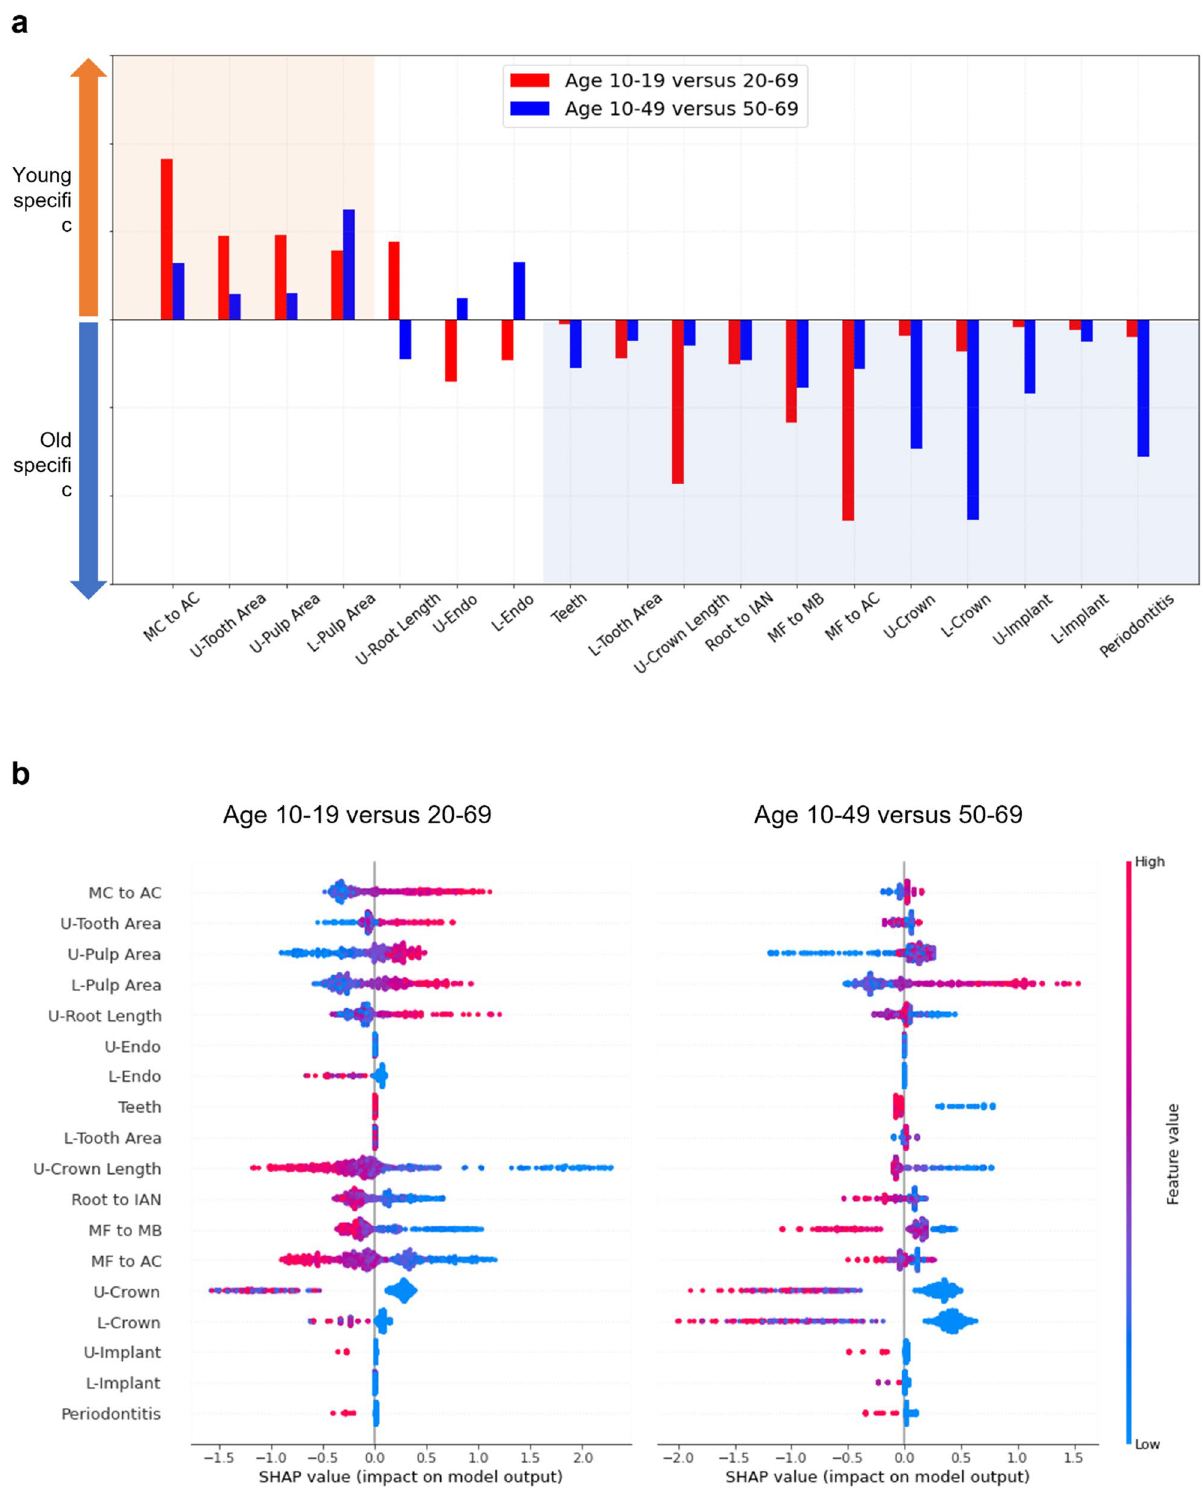
Figure 5. Feature analysis for LDA and XGBoost in young and old age group classifications ( a ) Learned weights of LDAs are shown as red bars (10–19 years versus 20–69 years) and old (10–49 years versus 50–69 years). The orange shaded area shows the features identified as young-specific: MC to AC, U-Tooth Area, U-Pulp Area, and L-Pulp Area. The light blue shaded area displays the old-specific features: Teeth, L-Tooth Area, U-Crown Length, Root to IAN, MF to MB, MF to AC, U-Crown, L-Crown, U-Implant, L-Implant, and Periodontitis. ( b ) SHAP values obtained from XGBoost in the classification of young and old age groups. Most of the young and old-specific features of XGBoost showed similar significance and age-related relationships to those of linear